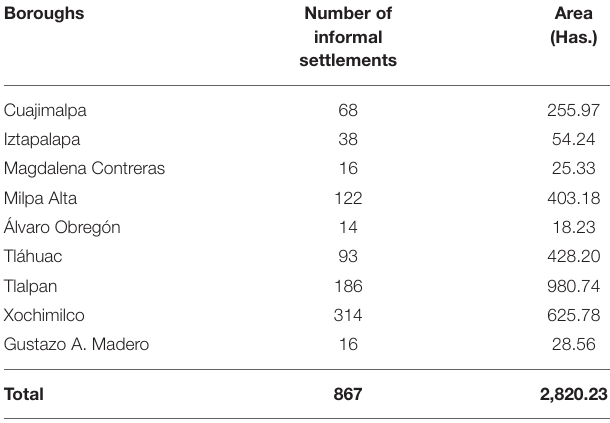
TABLE 3 | The conservation zone: number of informal settlements by borough 2008–2011.